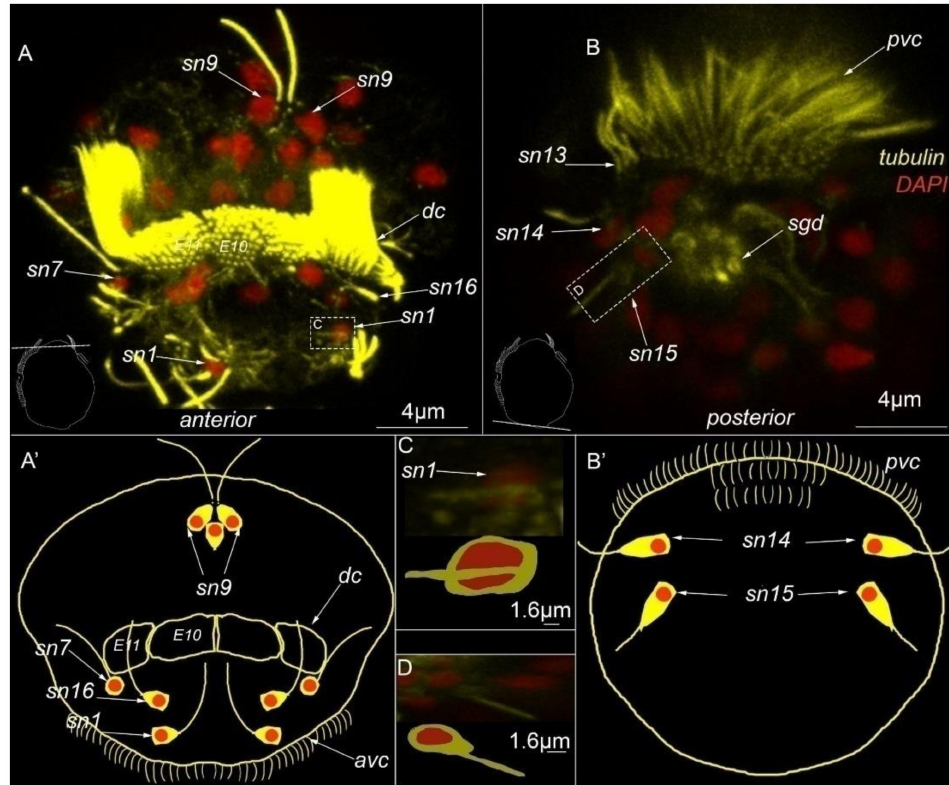
Figure 5. Type 1a sensory neurons in mature Dimorphilus gyrociliatus dwarf male revealed by anti- acetylated alpha-tubulin labeling. ( A , A (cid:48) ) Anterior surface view. ( A (cid:48) ) Schematic representation of the anterior surface. ( B ) The posterior surface view. ( B (cid:48) ) Schematic representation of the posterior surface view. ( C ) The close-up and drawing of sensory neuron № 1. ( D ) Close-up and drawing of sensory neuron № 2. Abbreviations: E10, 11 —multiciliated cells of the dorsal ciliary field; dc —dorsal cilia; pvc —posterior cilia; sgd —stylet gland cell; sn1 – sn20 —sensory neurons